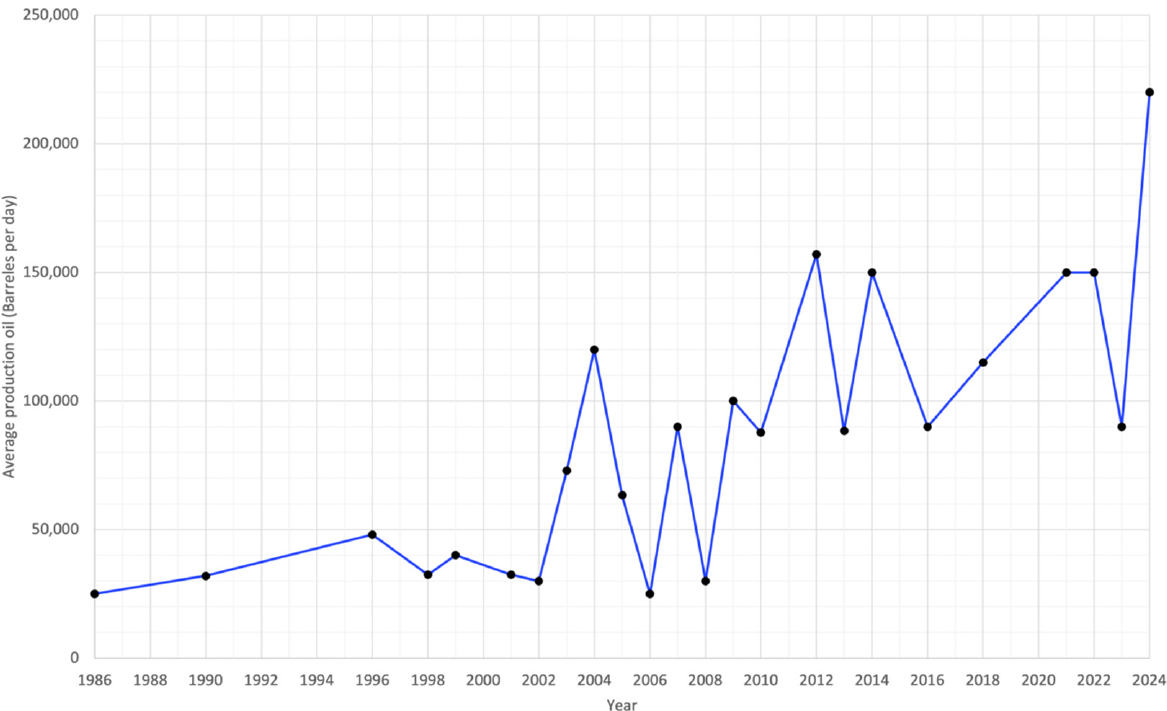
Figure 1. Average of daily oil production of FPSOs ordered to MODEC from 1986 to 2024. An increase in the oil production at the topside facilities of FPSOs will contain more gases, which leads to a rise in blow-by gas. The blow-by gas is defined as the discharge of the gas from a process component through a liquid outlet [12,13]. The blow-by gas occurs when free gas escapes with the liquid, which is caused by the failure of the gas pressure control valve installed in the separator to close [14]. When oil loading into the cargo tanks from the second stage separating system in a FPSO, there is a chance of delivery of the blow-by gas from the second stage separator to cargo tanks by the failure of the gas pressure control valve installed in the second stage separator. That is, the blow-by gas may be generated due to some causes such as clogging in a control valve installed in the separator after the general dry docking or at the initial start-up of the commissioning operation. This could lead to a dangerous situation for the safety of the FPSO such as the explosion of the cargo tanks [14]. The role of the blanket gas system, which is consist of an inert gas system and venting system [12], is becoming increasingly important to safely discharge large amounts of gas, such as blow-by gas, when it goes down to the cargo tanks. In addition, to properly discharge the increased blow-by gas, the current blanket gas system has the disadvantage that the pipe must be large. A novel blanket gas system is needed because of the difficulty of arrangement to the increases in the piping